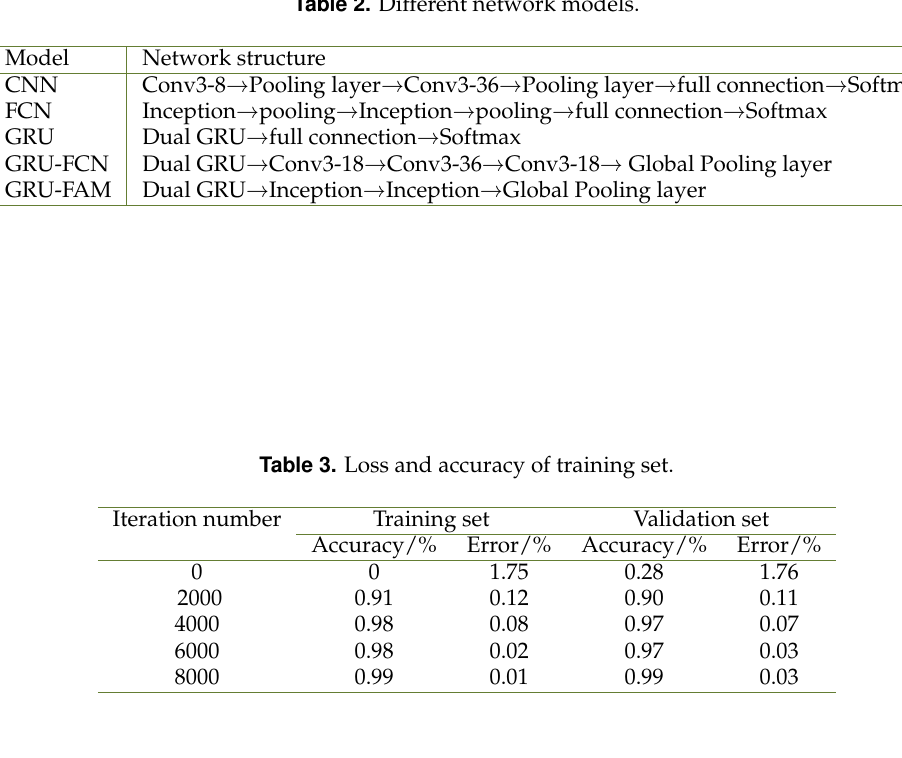
Table 2. Different network models.